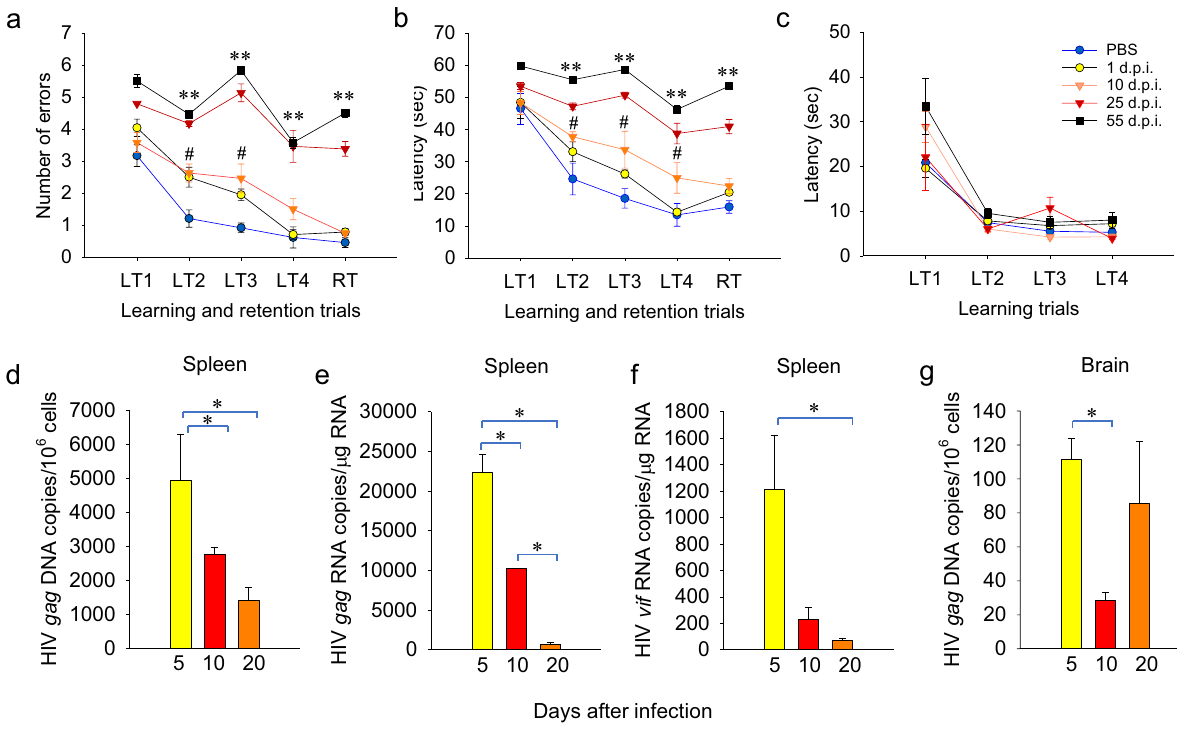
Figure 1. Kinetics of HIV-NCI development in EcoHIV infected C57BL/6 mice. Male 6–8-week-old C57BL/6 mice were infected with EcoHIV by IP injection and RAWM was performed 1, 10, 25, or 55 days later (n = 8 per condition/testing time post-infection, repeated once). Learning and short-term memory were measured by ( a ) mean number of errors ± standard errors of the mean (SEM) and ( b ) mean time ± SEM to find the hidden platform. ( c ) mean time ± SEM to find visible platform. LT1-LT4 denote acquisition trials and RT denotes the retention trial performed after a 30 min delay. RM ANOVA: ( a ) F(4,115) = 5.805, p < 0.001/ LT2; F(4,115) = 10.163, p < 0.001/LT3; F(4,115) = 13.715, p < 0.001/LT4; ( b ) F(4,115) = 5.310, p < 0.001/LT2; F(4,115) = 16.793, p < 0.001/LT3; F(4,115) = 20.639, p < 0.001/LT4. For RT values, see text. Pairwise comparison by Student’s t-test. PBS vs. EcoHIV 25 and 55 days after infection, **p < 0.01; PBS vs . EcoHIV 10 days after infection, # p < 0.05. ( d – g ) The experiment was repeated measuring EcoHIV burdens by QPCR in mice 5, 10, and 20 days after infection (n = 12 per group). ( d ) spleen HIV gag DNA, ( e ) spleen HIV gag RNA, ( f ) spleen HIV vif RNA, ( g ) brain HIV gag DNA. Pairwise comparison by t-test, *p <